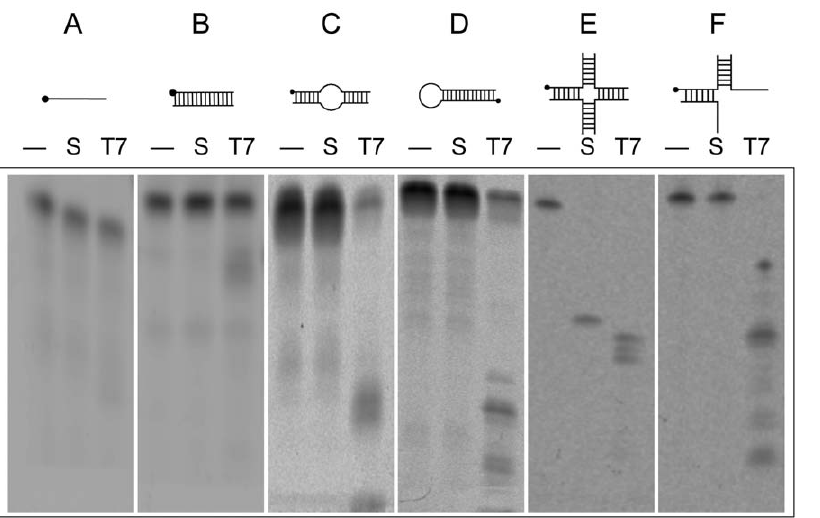
Figure 1. SIRV2 Hjr cleavage is specific to four-way junction DNA. Substrates (A: single-stranded DNA, B: double-stranded DNA, C: heteroduplex double-stranded DNA, D: hairpin DNA, E: four-way junction J3, F: three-way Holliday-like junction) were constructed as described in Materials & Methods and 5 9 labeled with fluorescence for detection (as indicated by a black circle). Distilled water (-), Hjr (S) (20 nM) or T7 endonuclease I (T7) (7.5 nM) was incubated with 100 nM substrate in 1 6 ThermoPol Buffer at 55 u C for 30 minutes. Reaction products were separated by 20% denaturing PAGE and fluorescence detected by a GE Typhoon scanner.